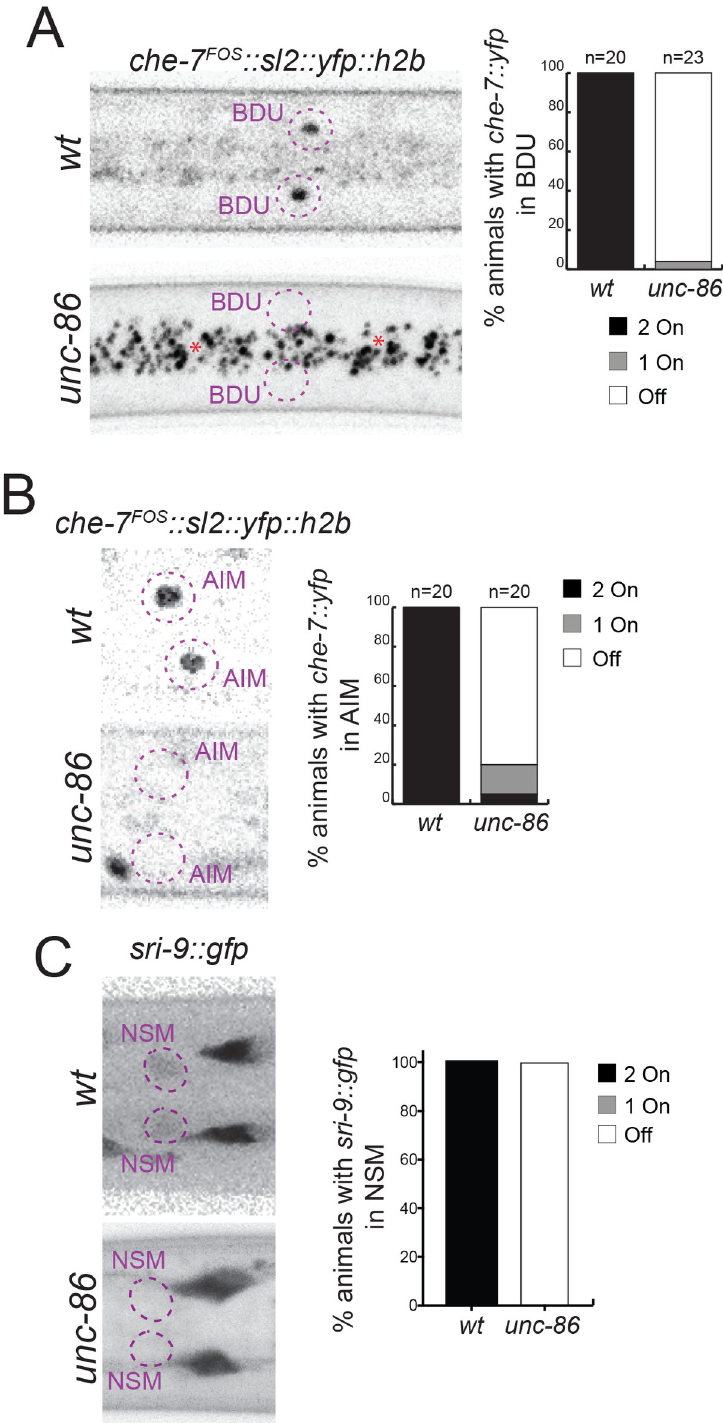
Fig 13. Dauer-specific expression of neuronal reporters depends on terminal selector-type TFs. (A) Dauer-specific expression of a che-7 fosmid reporter ( otEx7112 ) in BDU neurons is abolished in unc-86(n846) mutants. (B) Dauer- specific expression of a che-7 fosmid reporter ( otEx7112 ) in AIM neurons is abolished in unc-86(n846) mutants. (C) Dauer-specific expression of a sri-9 reporter ( otIs732 ) in NSM neurons is abolished in unc-86(n846) mutants. The data underlying this figure can be found in S1 Data. TF, transcription factor; wt, wild-type.